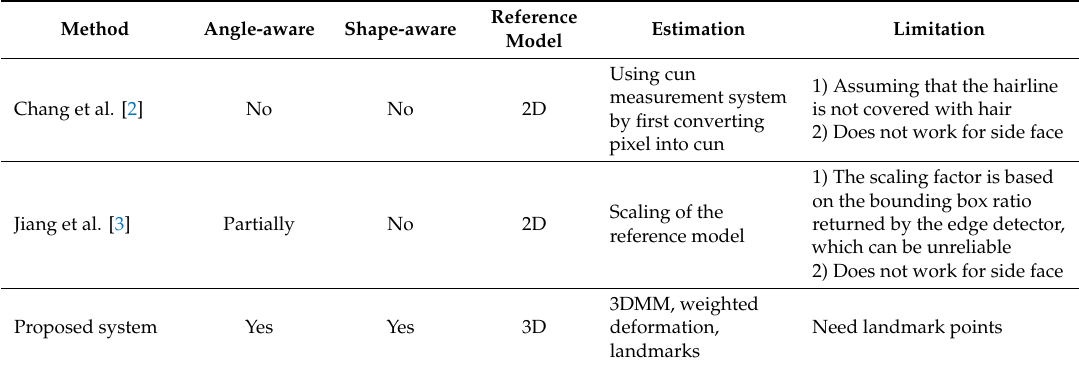
Table 1. Comparison of related